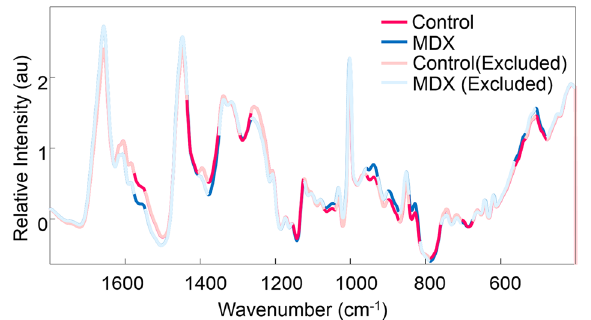
Figure 5. Genetic Algorithm analysis. Mean preprocessed dried blood serum spectra of the two classes, including the spectral ranges selected by Genetic Algorithm: control (pink) and MDX (blue). Areas selected by Genetic Algorithm are marked by bolded lines. Spectral regions deemed as uninformative for discrimination are seen as unfilled lines.